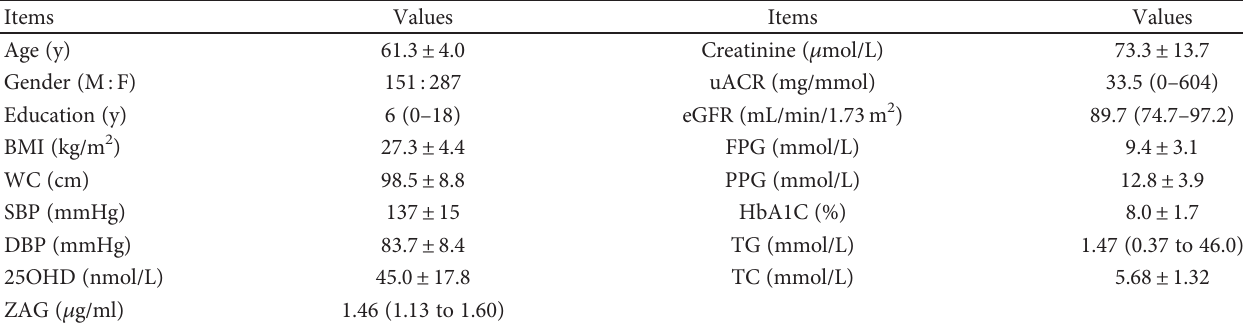
Table 1: Clinical and biochemical characteristics of the study participants ( N =438) [mean ± SD or median (interquartile range)].